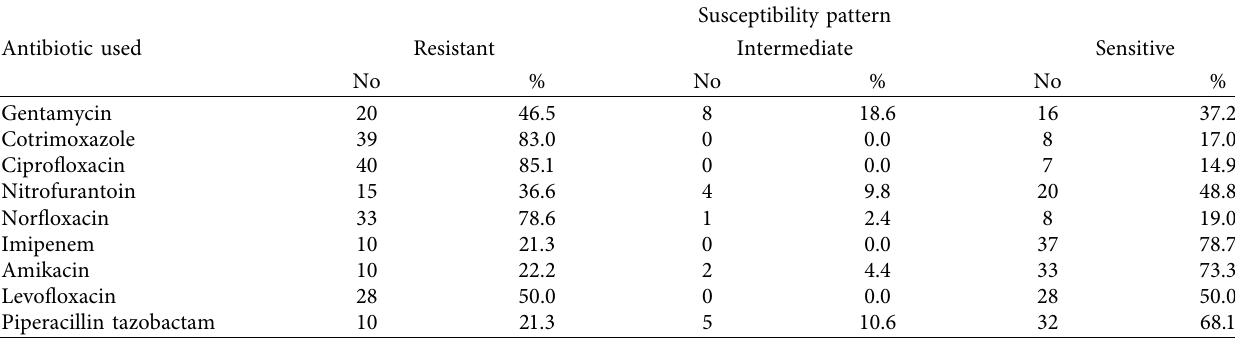
Table 4: Antibiotic resistance pattern of ESBL producers ( n � 47).